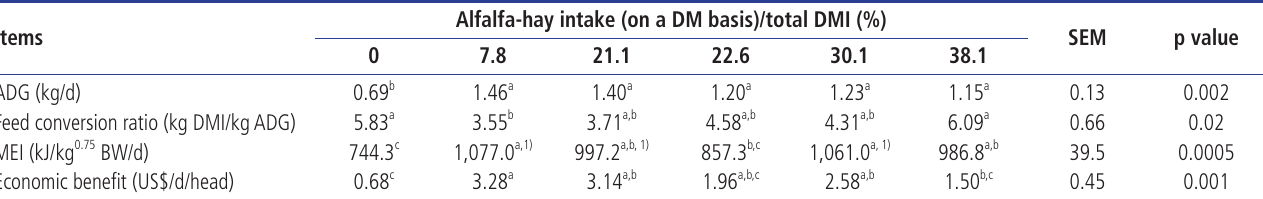
Table 7. Growth performance, energy intake, and economic benefit of Simmental crossbred male calves with different alfalfa-hay intakes (September to October 2015 and August to September 2016)